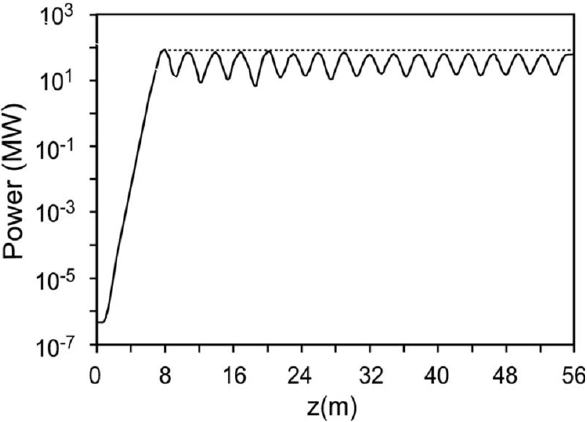
Figure 12. Power growth and oscillation after saturation (no specific parameters of the simulation have been inserted because we are just interested to the oscillating behavior, characterizing any SASE FEL operating with constant parameters).